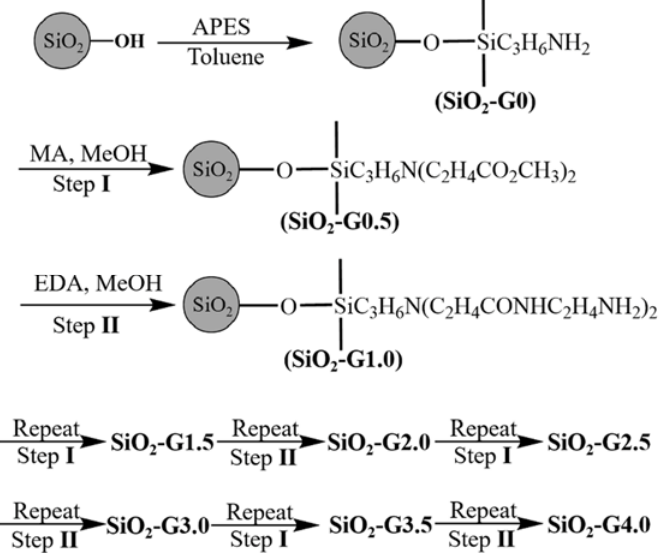
Figure 4. Ideal synthetic routes of ester- and amino-terminated dendrimer-like PAMAM polymers- grafted silica gel. Reprinted with permission from Ref. [43]. 2006, Elsevier.